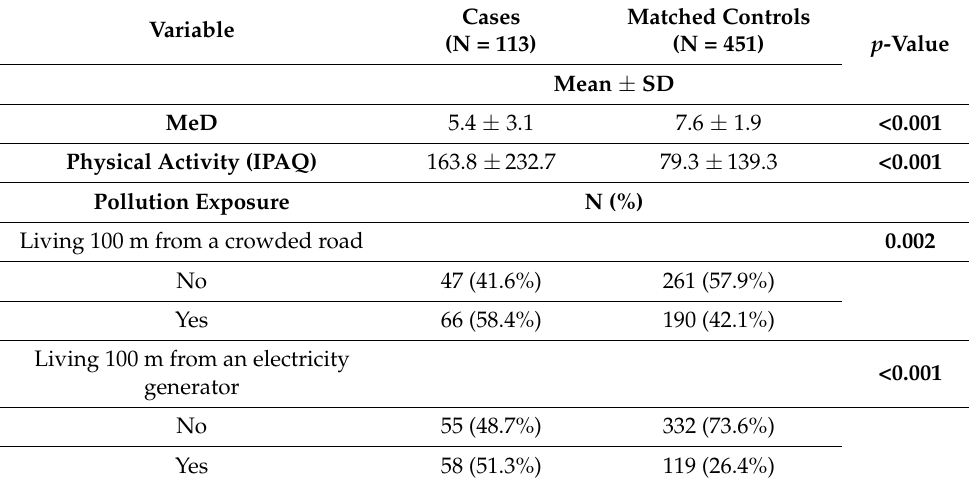
Table 2. Bivariate analysis of other factors associated with ischemic stroke.